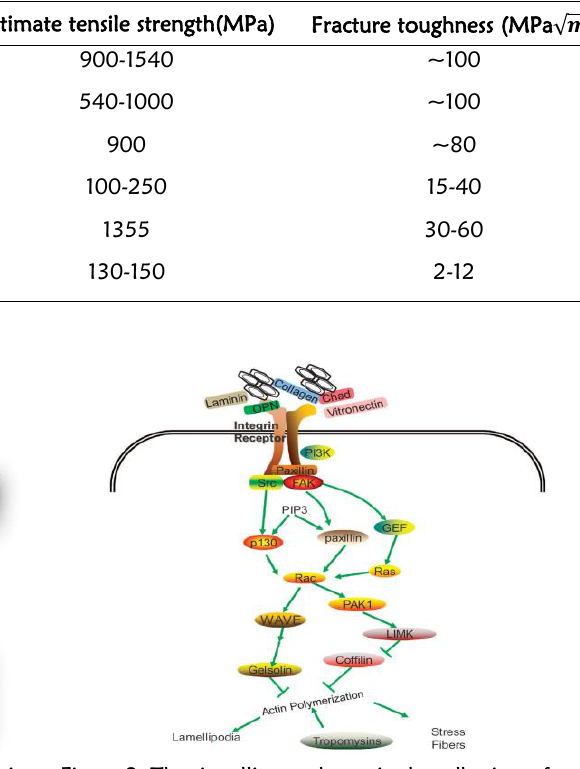
Figure 1: a) surface properties b) mechanical properties of stem cells [10].